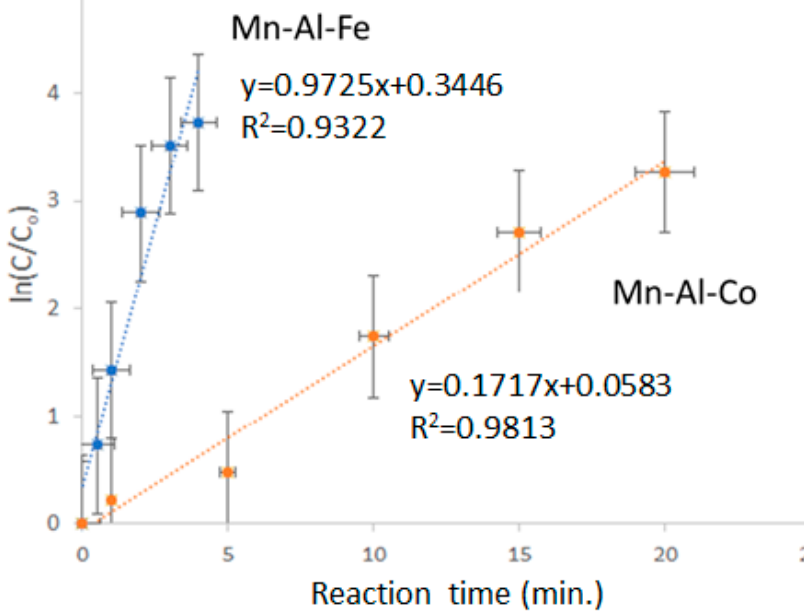
Figure 4. Ln(C / C o ) versus reaction time of the MA Mn-Al-Fe and Mn-Al-Co Figure 4. Ln(C/C o ) versus reaction time of the MA Mn-Al-Fe and Mn-Al-Co alloys.